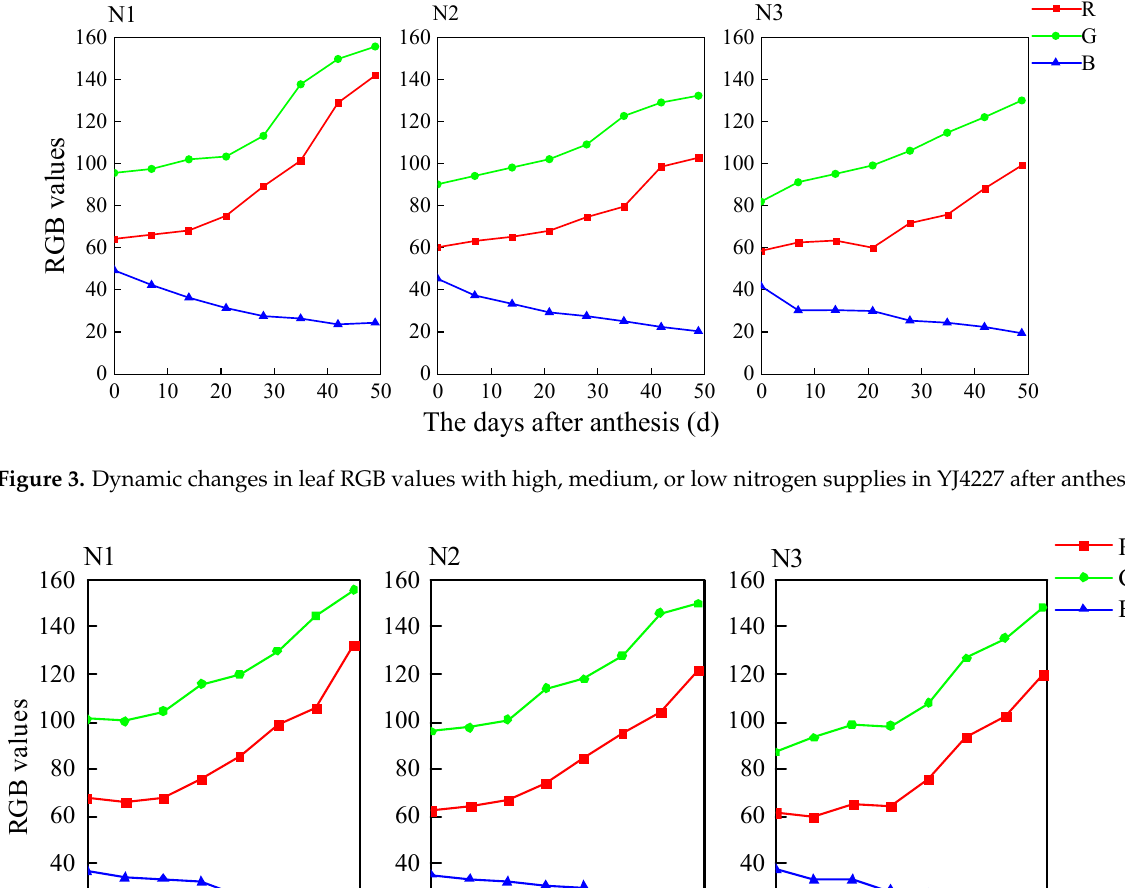
Figure 2. Dynamic changes in leaf RGB values with high, medium, or low nitrogen supplies in HD5 after anthesis.